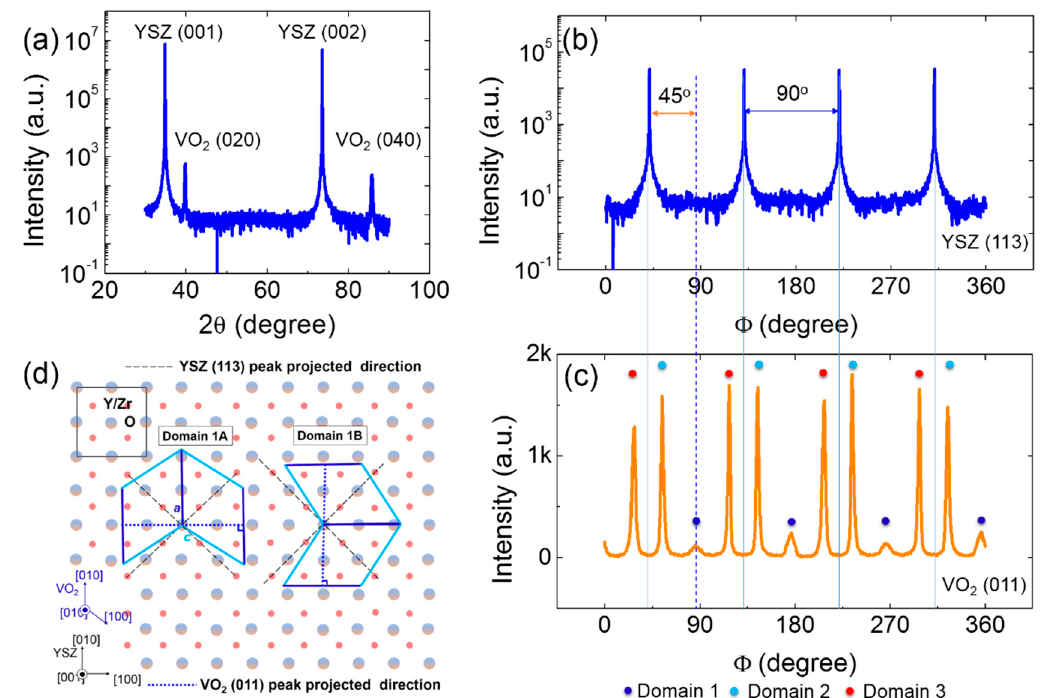
Figure 1. ( a ) XRD θ –2 θ scans for the (010)-VO 2 /(001)-YSZ thin films; ( b ) The Φ scan of the substrate YSZ (113) peaks; ( c ) The Φ scan of the VO 2 (011) peaks; ( d ) The schematic of the domain structures of the VO 2 epitaxial thin film on the YSZ substrate.